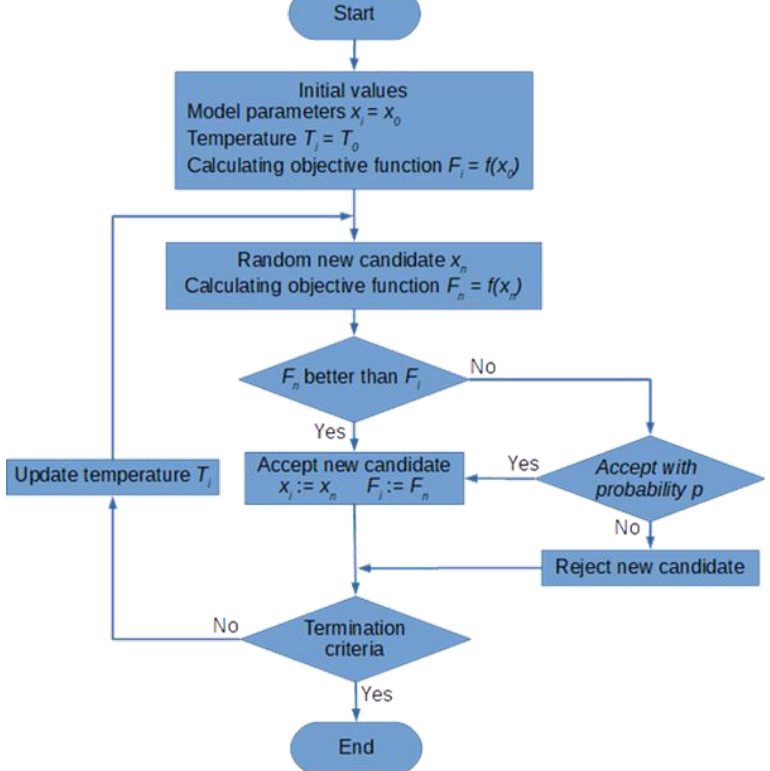
Figure 2. Flowchart of the simulated annealing method [34].